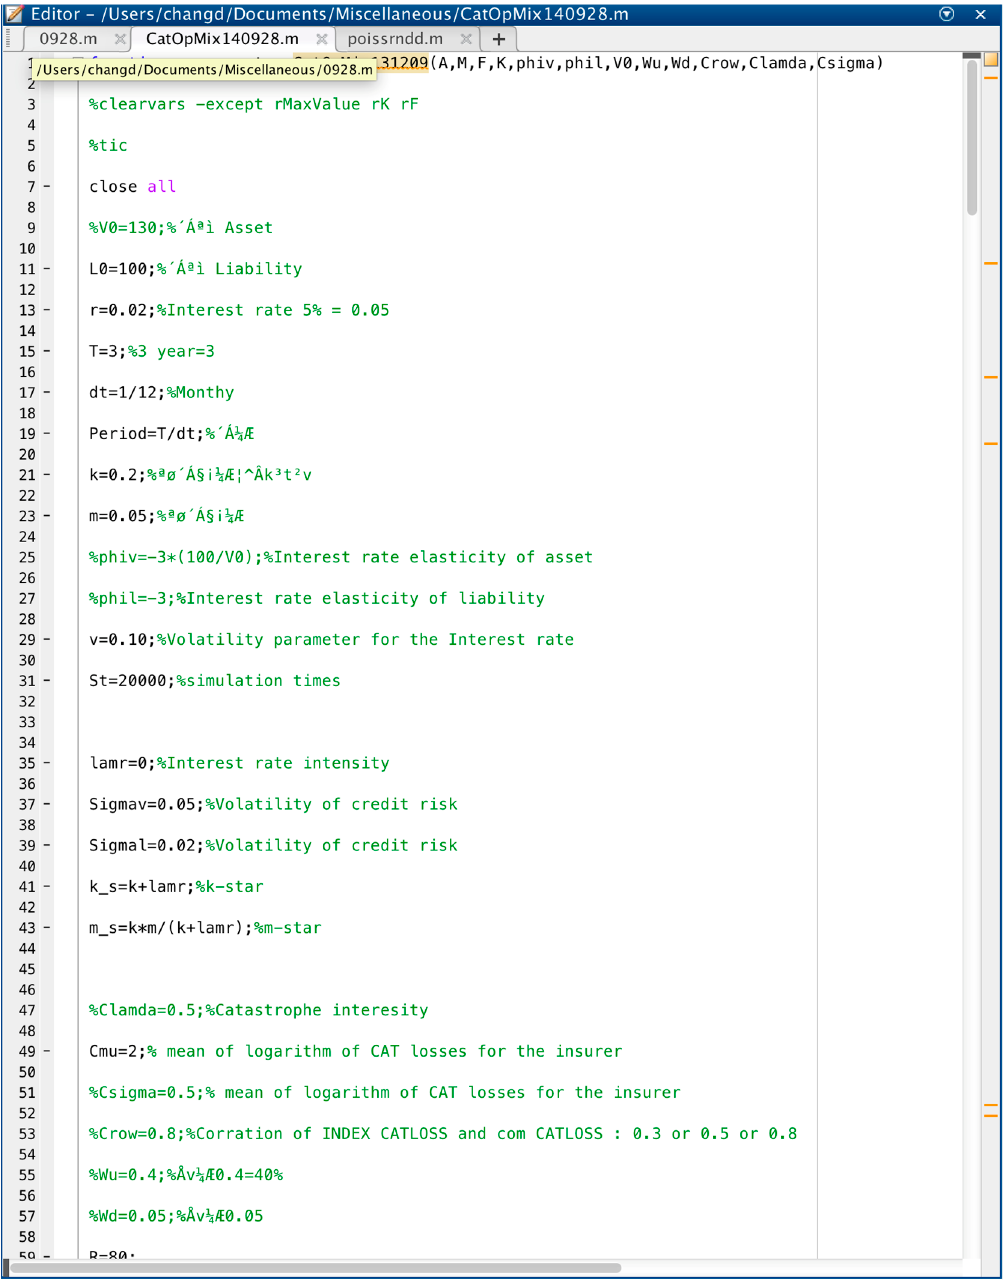
Figure A1. MATLAB code for the asset, liability, and interest rate processes.